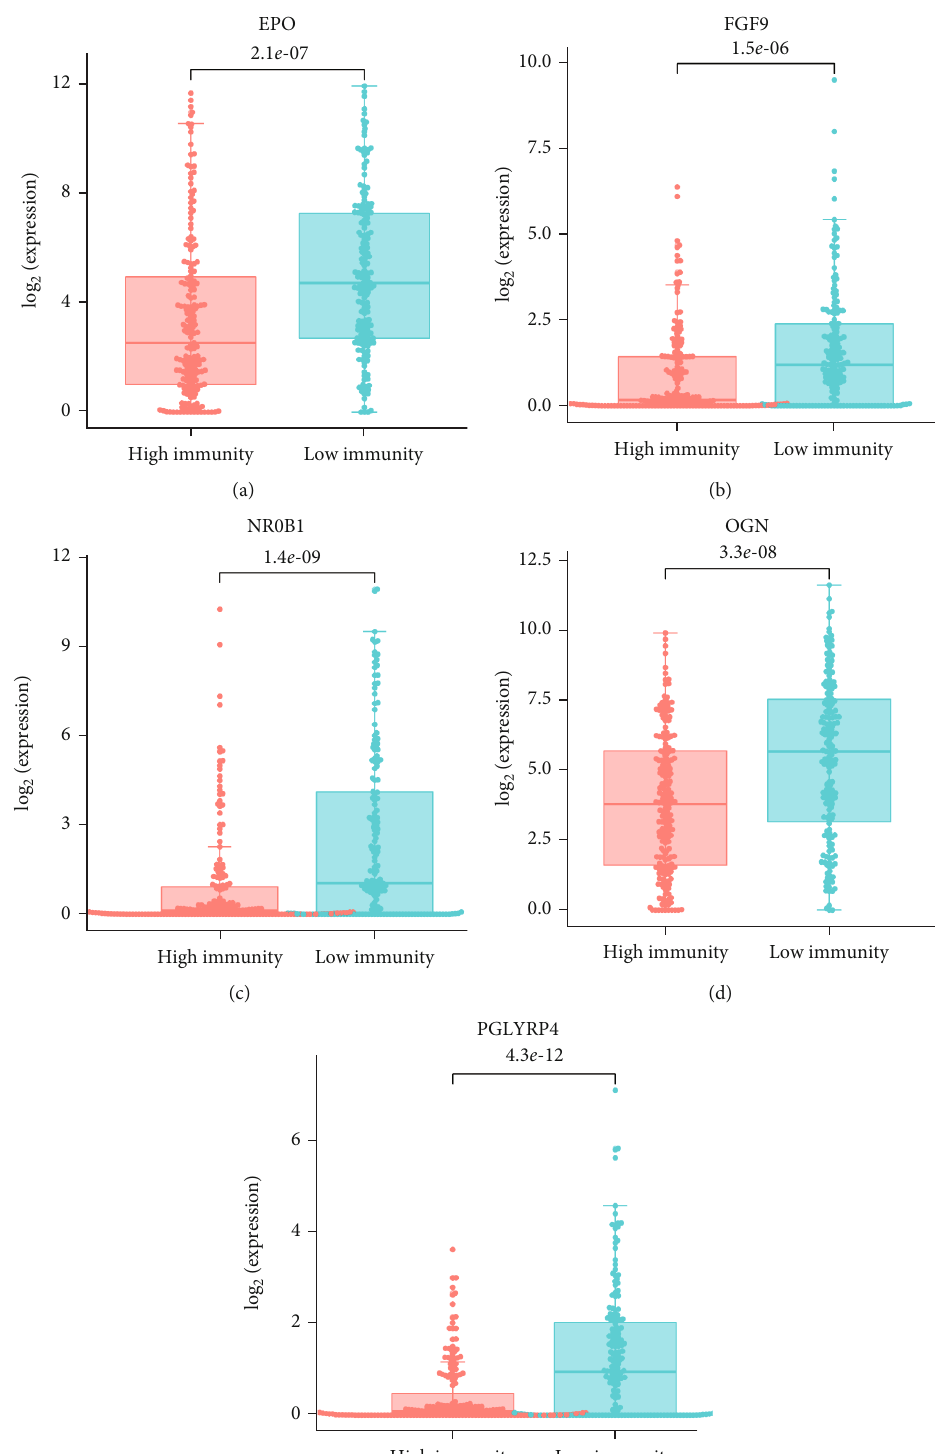
Figure 5: Box plot of expression levels of 5 genes between high- and low-immune subtypes. EPO (a), FGF9 (b), NR0B1 (c), OGN (d), and PGLYRP4 (e) levels between high- and low-immune